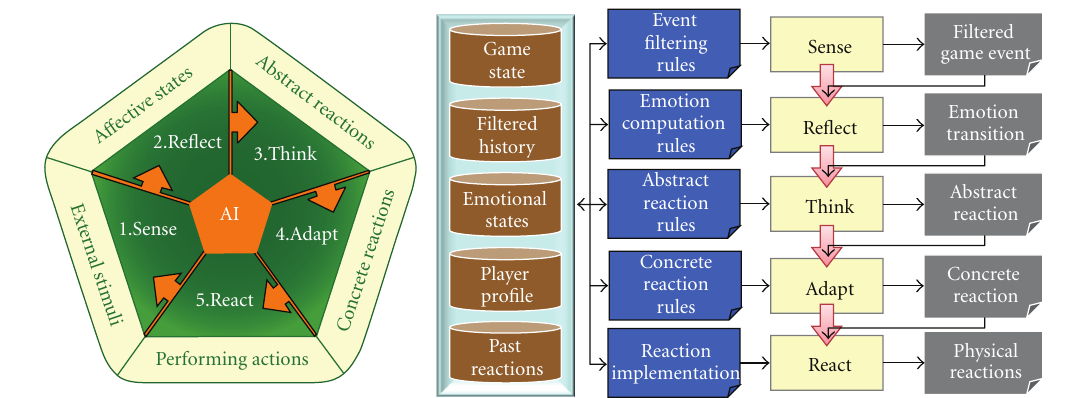
Figure 3: The proposed behavior loop for game presenter characters. Although not shown for clarity reasons, the output of each state is available to subsequent states if